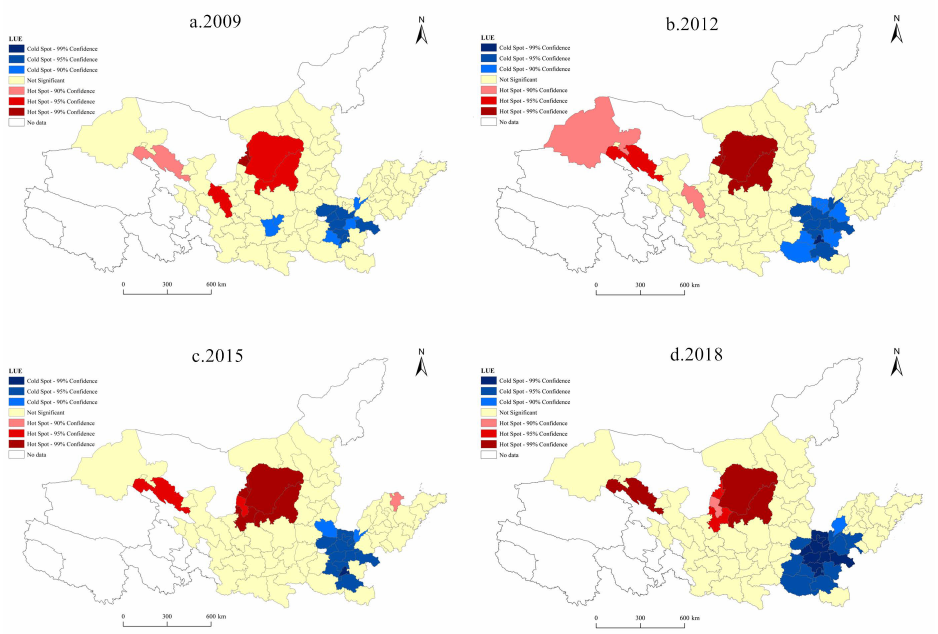
Figure 8. Development of the cold and hot spots of the LUE in the Yellow River Basin from 2009 to 2018.